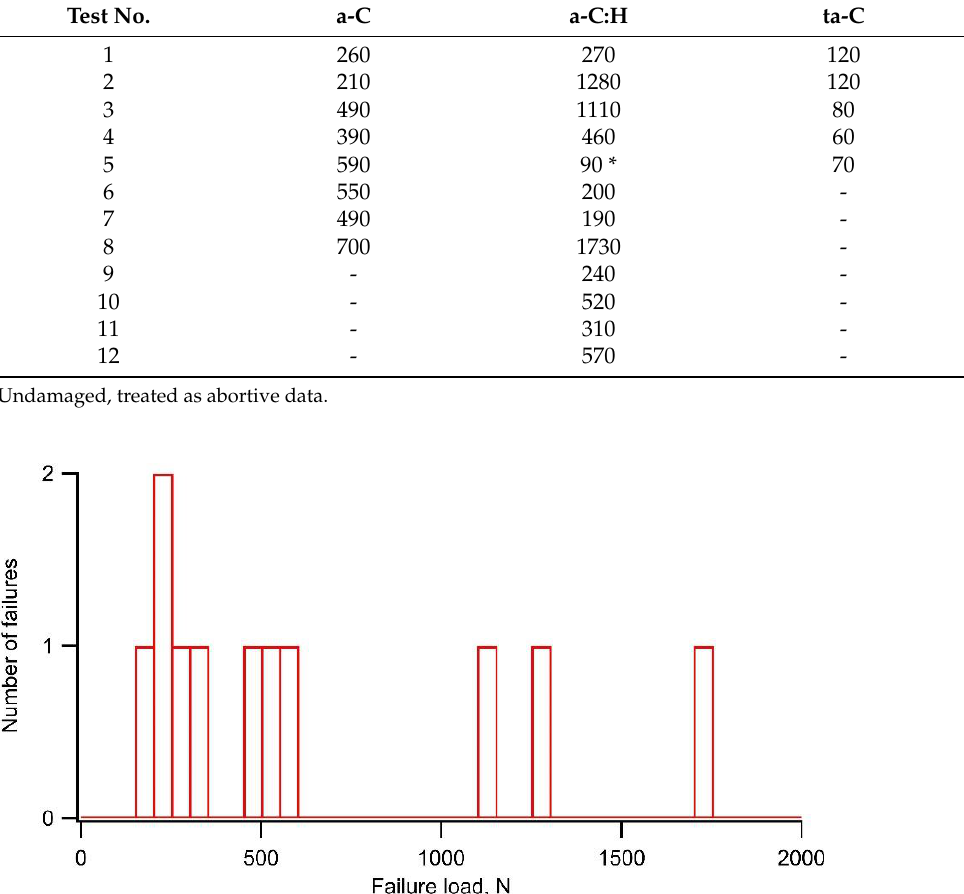
Table 2. Test results of failure load on DLC films (a-C, a-C:H, and ta-C). Values are in N. Test No.